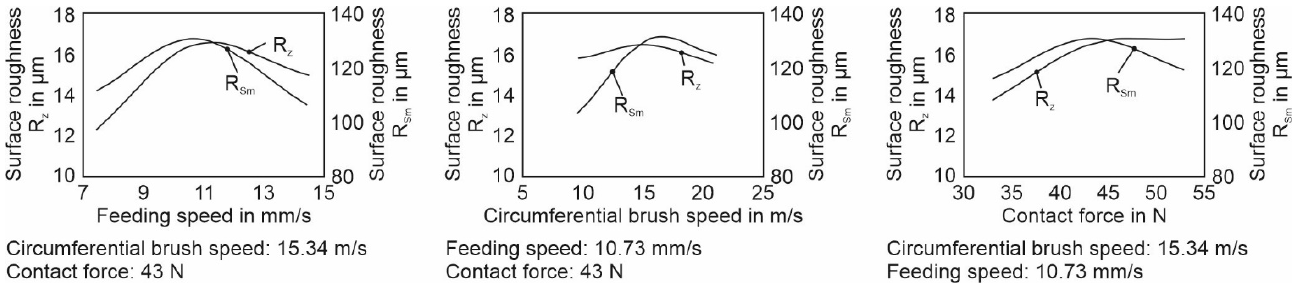
Figure 3. Influence of brushing parameters on the surface roughness of brushed Mg sheets.